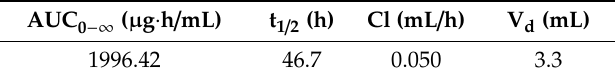
Figure 7. ( a ) Time course profile of a-PD-L1 plasma concentrations collected from tumor-bearing mice at different time points after receiving the first dose ( n = 3/time). Experimental data are represented by points, and solid lines correspond to the mean (left panel). ( b ) Box plots represent the plasma concentrations at 10, 30, and 60 min after the first and fourth administrations; symbols show the observed data (right panel). Table 7. Drug exposure expressed as AUC 0 −∞ after first dose administration and the parameters, t 1 / 2 , Cl, and V d calculated by linear